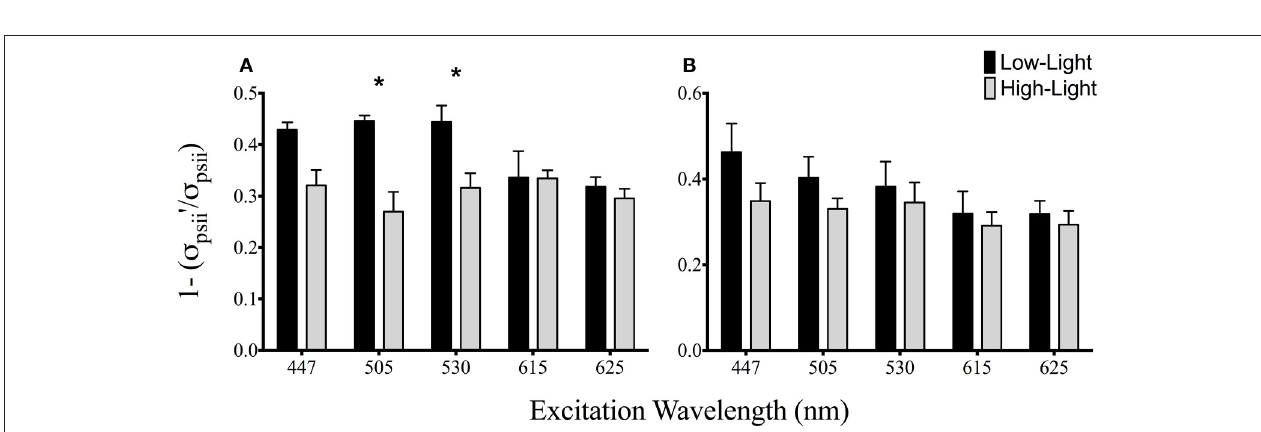
FIGURE 4 | Spectrally dependent antennae bed non-photochemical quenching for A4-a (A) and B1-a Symbiodinium (B) . Bars represent the mean and ± SE for (black) low and (gray) high light acclimated samples. Asterisks represent significant differences between low and high light conditions.